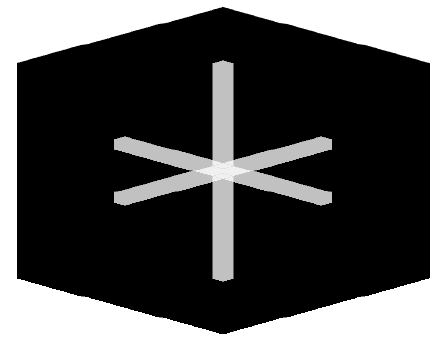
Figure 2. A three-dimensional representation of the reference feature used in normalized cross